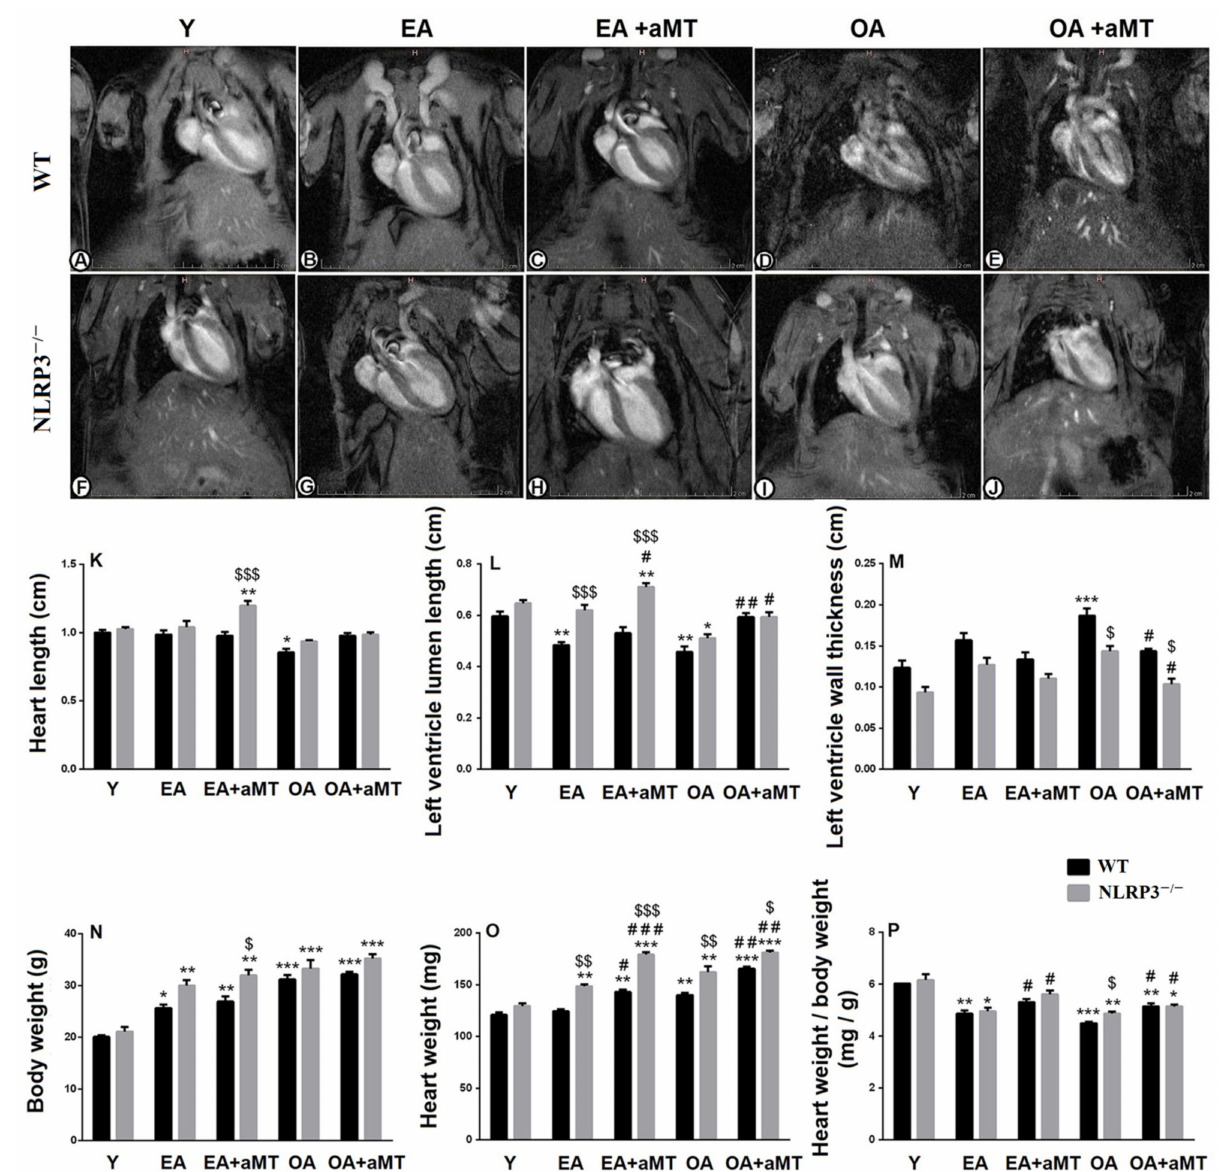
Figure 1. Impact of NLRP3 deficiency and melatonin therapy on cardiac magnetic resonance imaging and anthropometric parameters during aging. ( A – E ) Magnetic resonance imaging of the heart of young (Y), early-aged (EA), early-aged with melatonin (EA + aMT), old-aged (OA), and old-aged with melatonin (OA + aMT) WT mice. ( F – J ) Magnetic resonance imaging of the heart of Y, EA, EA + aMT, OA, and OA + aMT NLRP3 − / − mice. ( K ) Analysis of the heart length (cm). ( L ) Analysis of the luminal length of the left ventricle (cm). ( M ) Analysis of the thickness of the left ventricular wall (cm). ( N ) Analysis of the body weight (g). ( O ) Analysis of the heart weight (mg). ( P ) Analysis of the ratio of the heart weight to the body weight (mg/g). * p < 0.05, ** p < 0.01 and *** p < 0.001 vs. Y; # p < 0.05, ## p < 0.01 and ### p < 0.001 vs. aged group without melatonin; $ p < 0.05, $$ p < 0.01 and $$$ p < 0.001 vs. WT